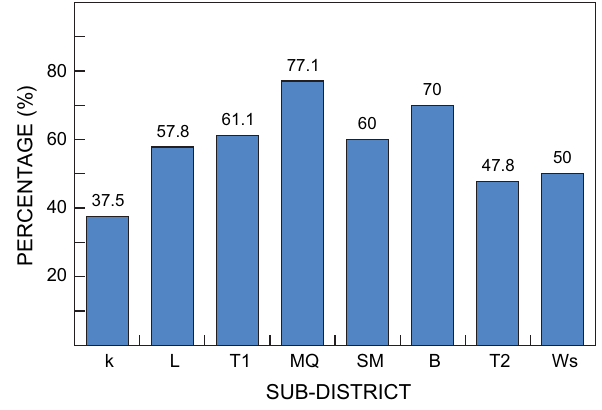
(2014).[K, L, T1, MQ, SM B, T2, Ws are clinic abbreviations for Figure 2: Suppressed viral loads of children in one subdistrict